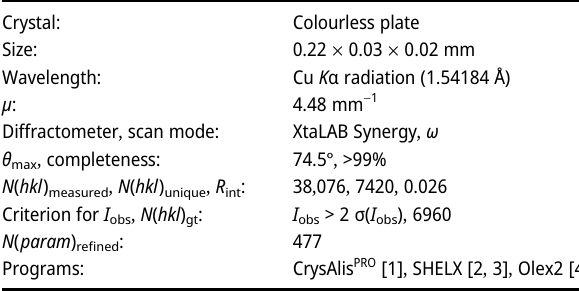
Table  : Data collection and